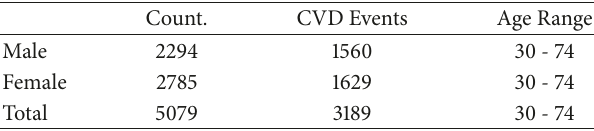
Table 1: CVD event distribution in male and female.